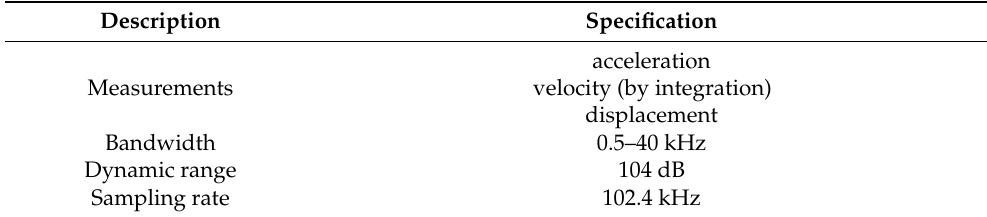
Figure 3. Schematic of tools and workpieces used in cutting. ( a ) Information on workpieces used for cutting; ( b ) information on tools used for cutting; ( c ) accelerometer used for vibration measurement and direction of measurement; ( d ) spindle at vibration measuring position; ( e ) hydraulic chuck to hold the workpiece; and ( f ) Vibration data collector used for vibration measurement. Table 5. Specifications of the vibration data collector used in the experiment.